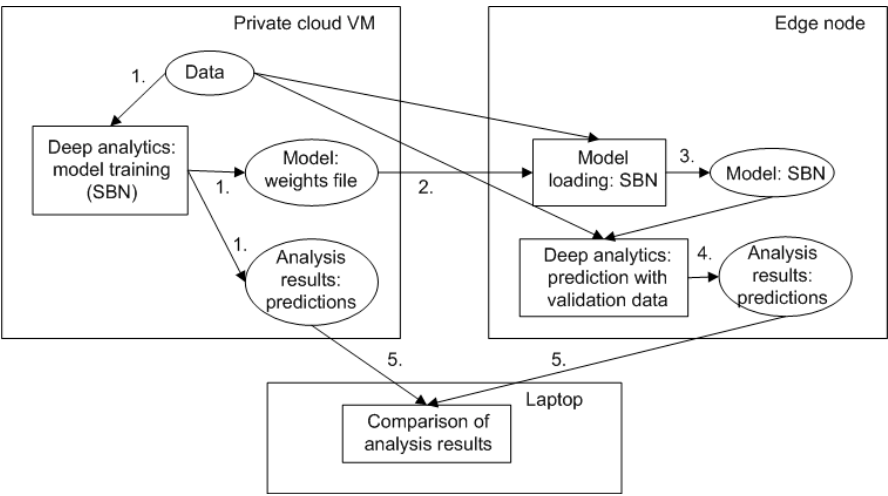
Figure A1. Architecture design for evaluating feasibility of predictions in edge nodes. Feasibility evaluation: